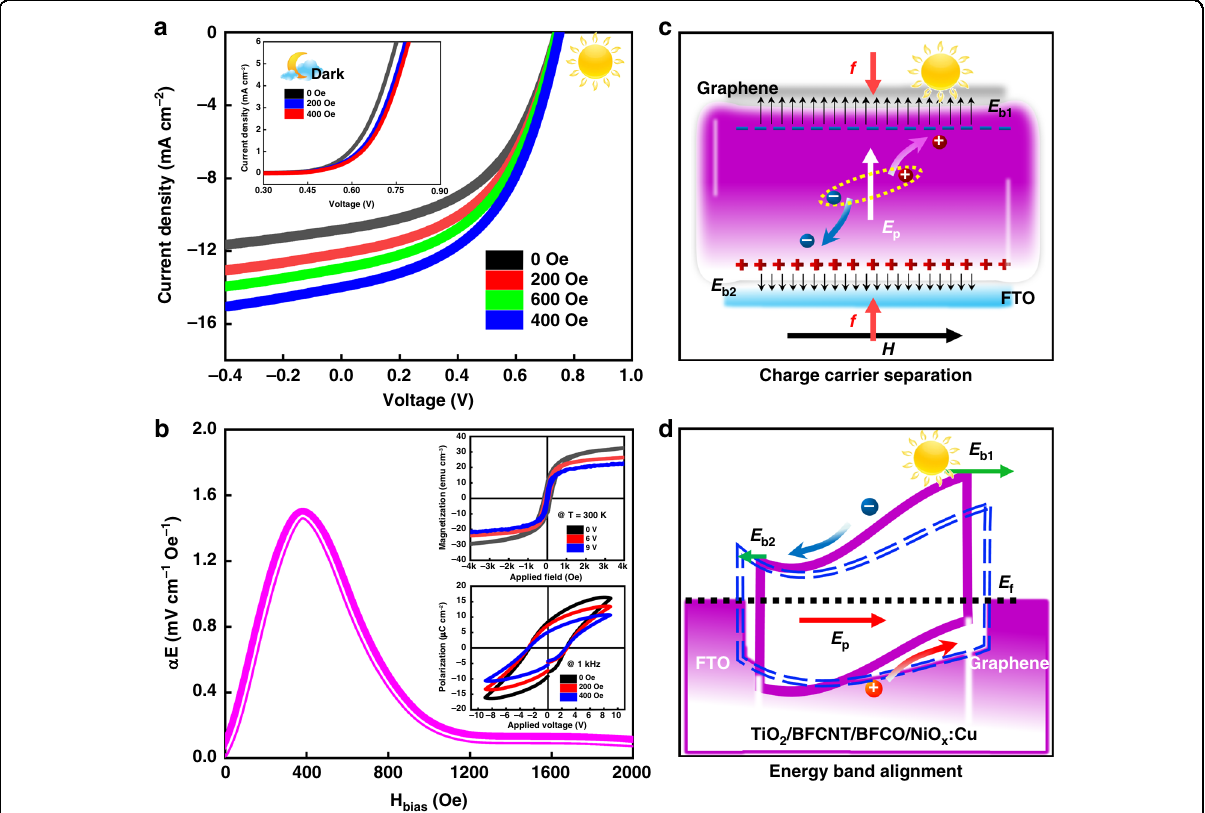
Fig. 5 Modulation of magnetization on photovoltaic properties. a J-V characteristics under different magnetic fi eld intensities. b The magnetoelectric coupling coef fi cient ( α E ) along with the applied magnetic fi eld, the insets show mutual regulations of electric and magnetic fi elds. c and d Schematic of both micro-deformation and energy band alignment under